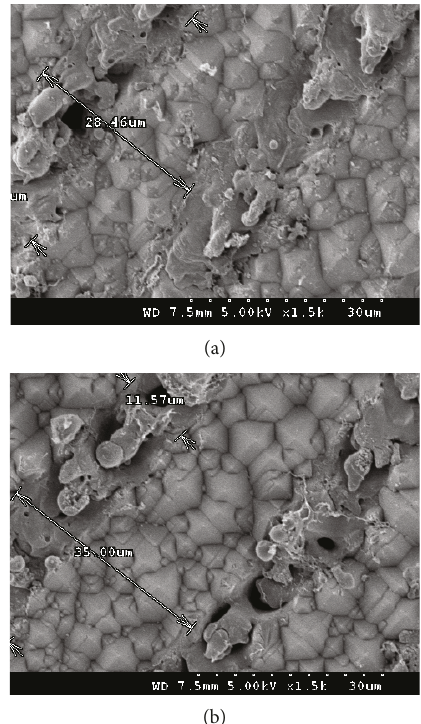
Figure 9: FESEM surface morphology images of backside surfaces of SPMSCs with various KOH etching times of (a) 30 and (b)